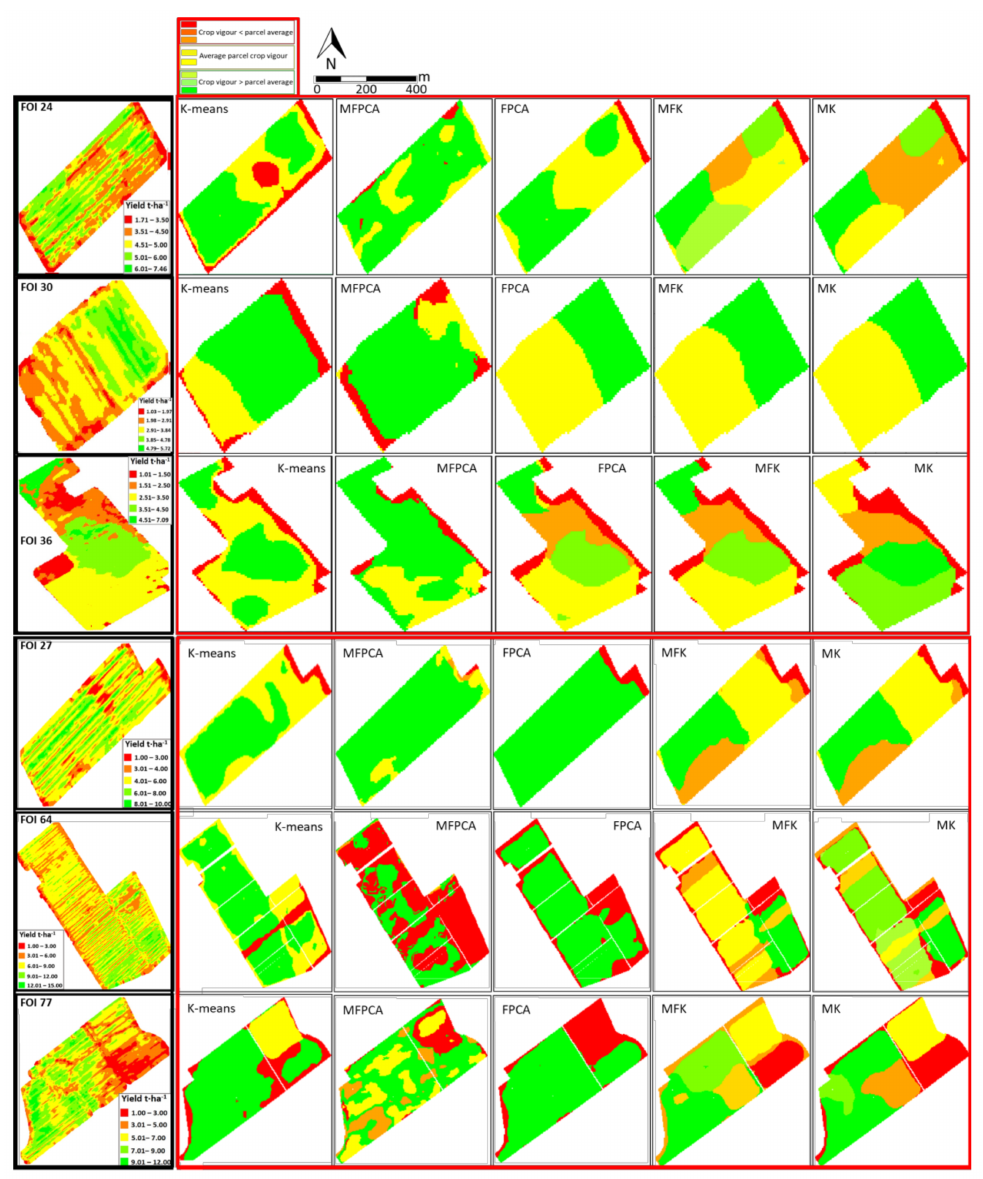
Figure 5. Examples of the actual yield maps (left images) and clustering results obtained with the different methods (K-means, MFPCA, FPCA, MFK, and MK) for six of the validation FOIs (24, 30, 36, 27, 64, and 77). The geographic coordinates of the center of the FOIs are: (FOI24: 41 ◦ 53 (cid:48) 49”N, 12 ◦ 12 (cid:48) 23”E), (FOI30: 41 ◦ 53 (cid:48) 06”N, 12 ◦ 11 (cid:48) 42”E), (FOI36: 41 ◦ 53 (cid:48) 37”N, 12 ◦ 13 (cid:48) 12”E), (FOI27: 41 ◦ 53 (cid:48) 43”N, 12 ◦ 12 (cid:48) 31”E), (FOI64: 41 ◦ 51 (cid:48) 42”N, 12 ◦ 13 (cid:48) 25”E), (FOI77: 41 ◦ 51 (cid:48) 36”N 12 ◦ 14 (cid:48)